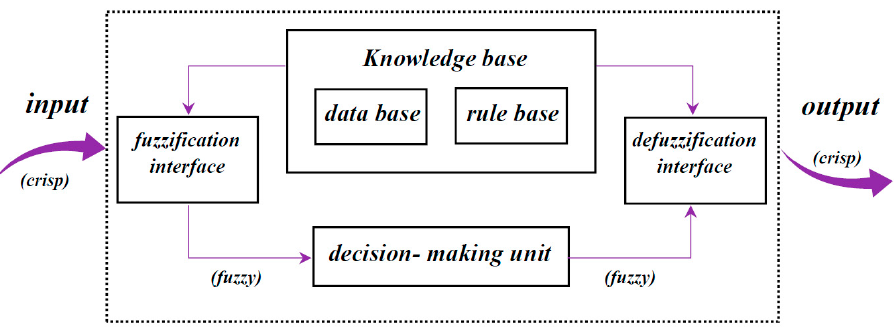
Figure 10. A fuzzy inference system.